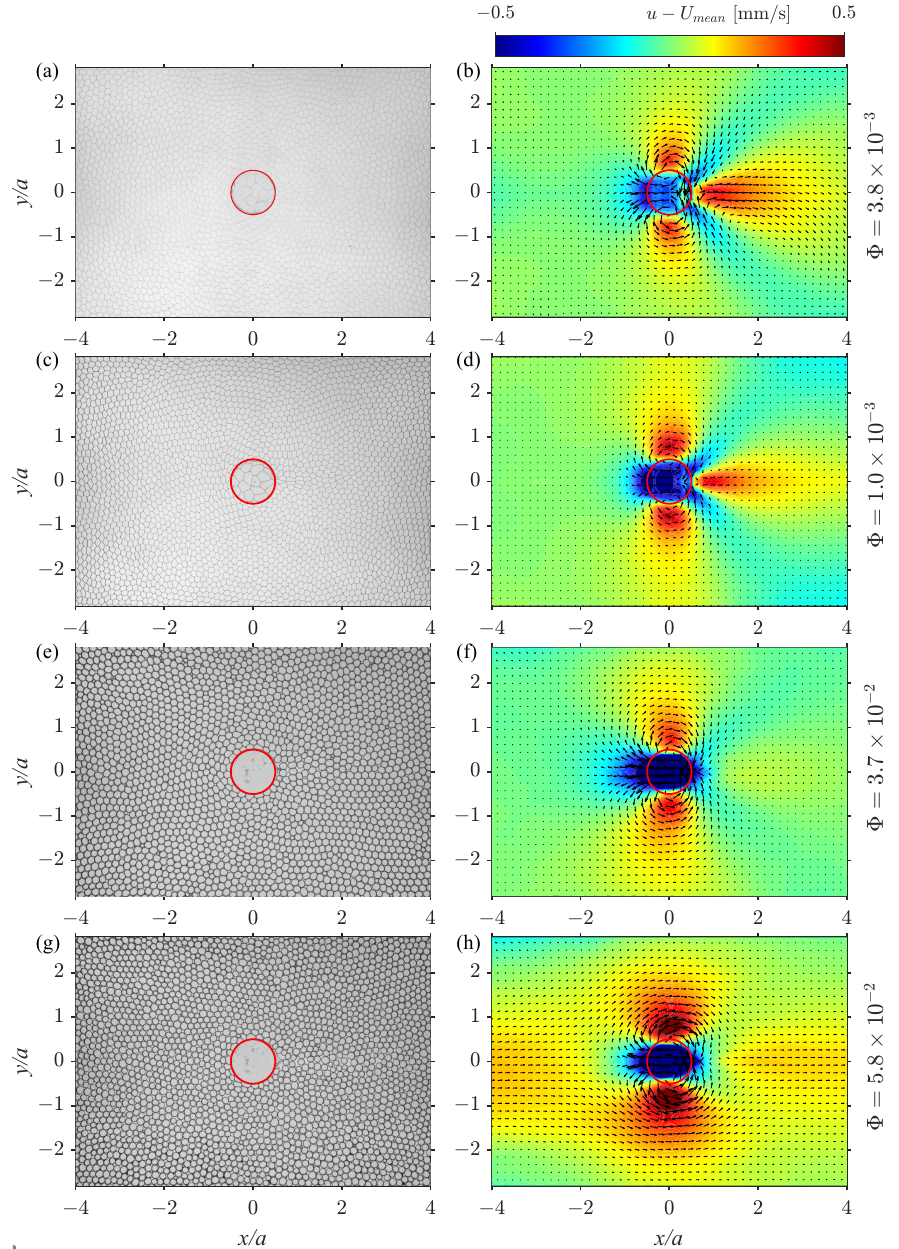
Figure 3. Original images of the foam (on the left) and longitudinal velocity component averaged over 125 s with subtracted mean velocity u − U mean (color) together with the velocity vector field U − U mean (on the right) for various liquid fraction Φ : ( a , b ) 3.8 × 10 − 3 , ( c , d ) 1.0 × 10 − 2 , ( e , f ) 3.7 × 10 − 2 and ( g , h ) 5.8 × 10 − 2